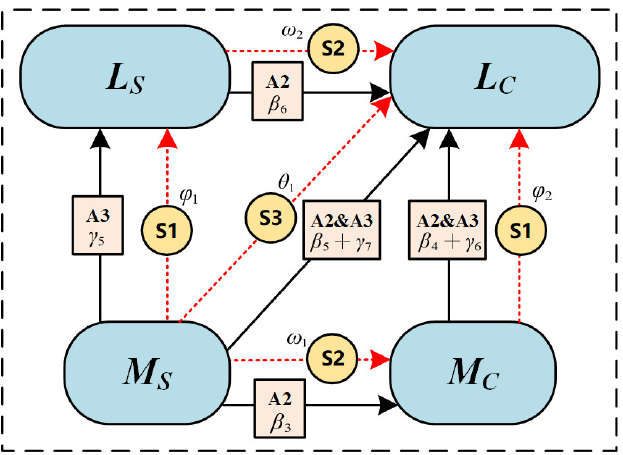
Figure 3. Optimized mechanism implementation in collaborative state evolutionary model.